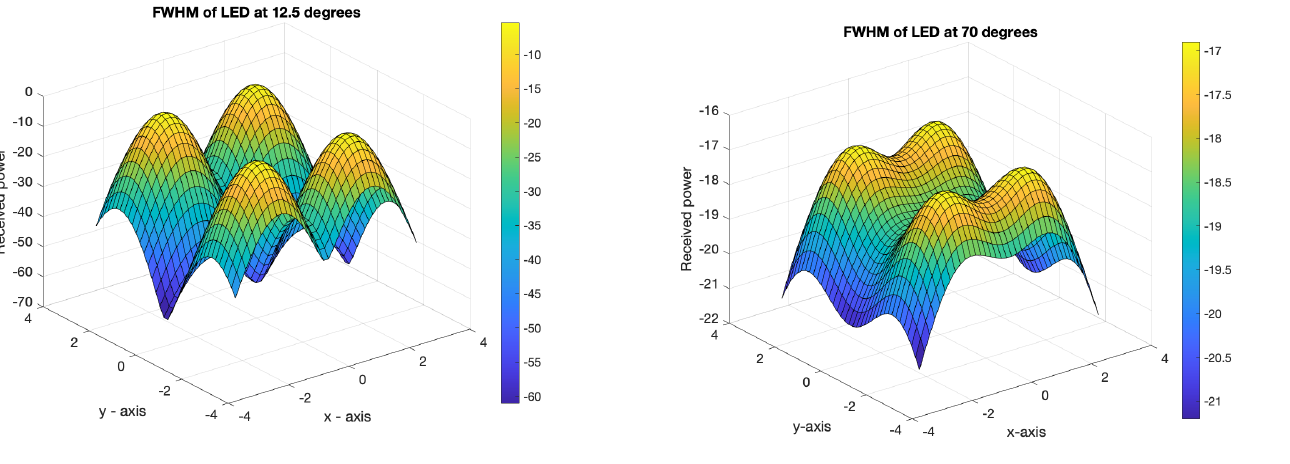
Figure 2. FWHM at two different